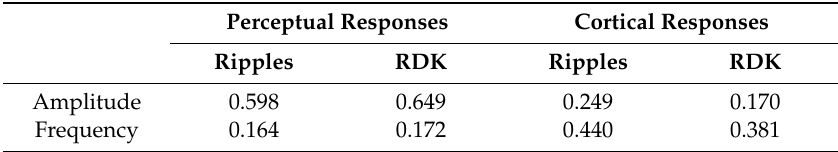
Table 4. Estimates of e ff ect size (partial η 2 ) of video speed modulation amplitude and frequency on perceptual and cortical responses, shown separately for Ripples and RDK